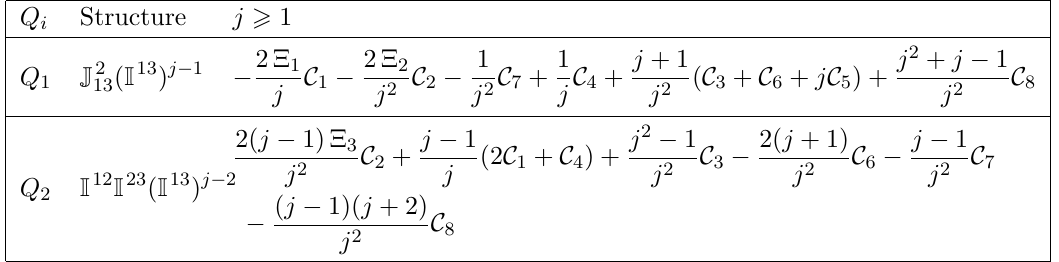
Table 18 . Expansion of the supersymmetric correlator in the component has spin (0 ; 1 ( j 1)) and QO has spin ( 1 2 (cid:0) to zero and removing the last row. Furthermore we de(cid:12)ned C 6